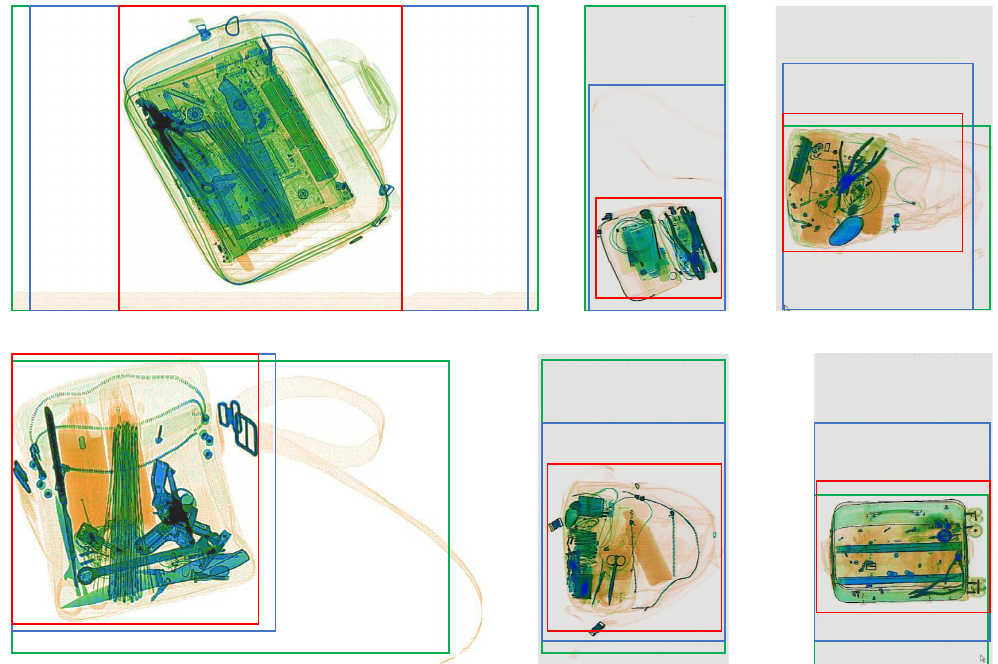
Figure 9. Comparison of cropping output between different methods: Green bounding boxes indicate the outputs from Canny edge [40]-based cropping; Blue bounding boxes indicate the outputs from aesthetic-based cropping [24]; Red bounding boxes indicate the outputs from our proposed TDC module.